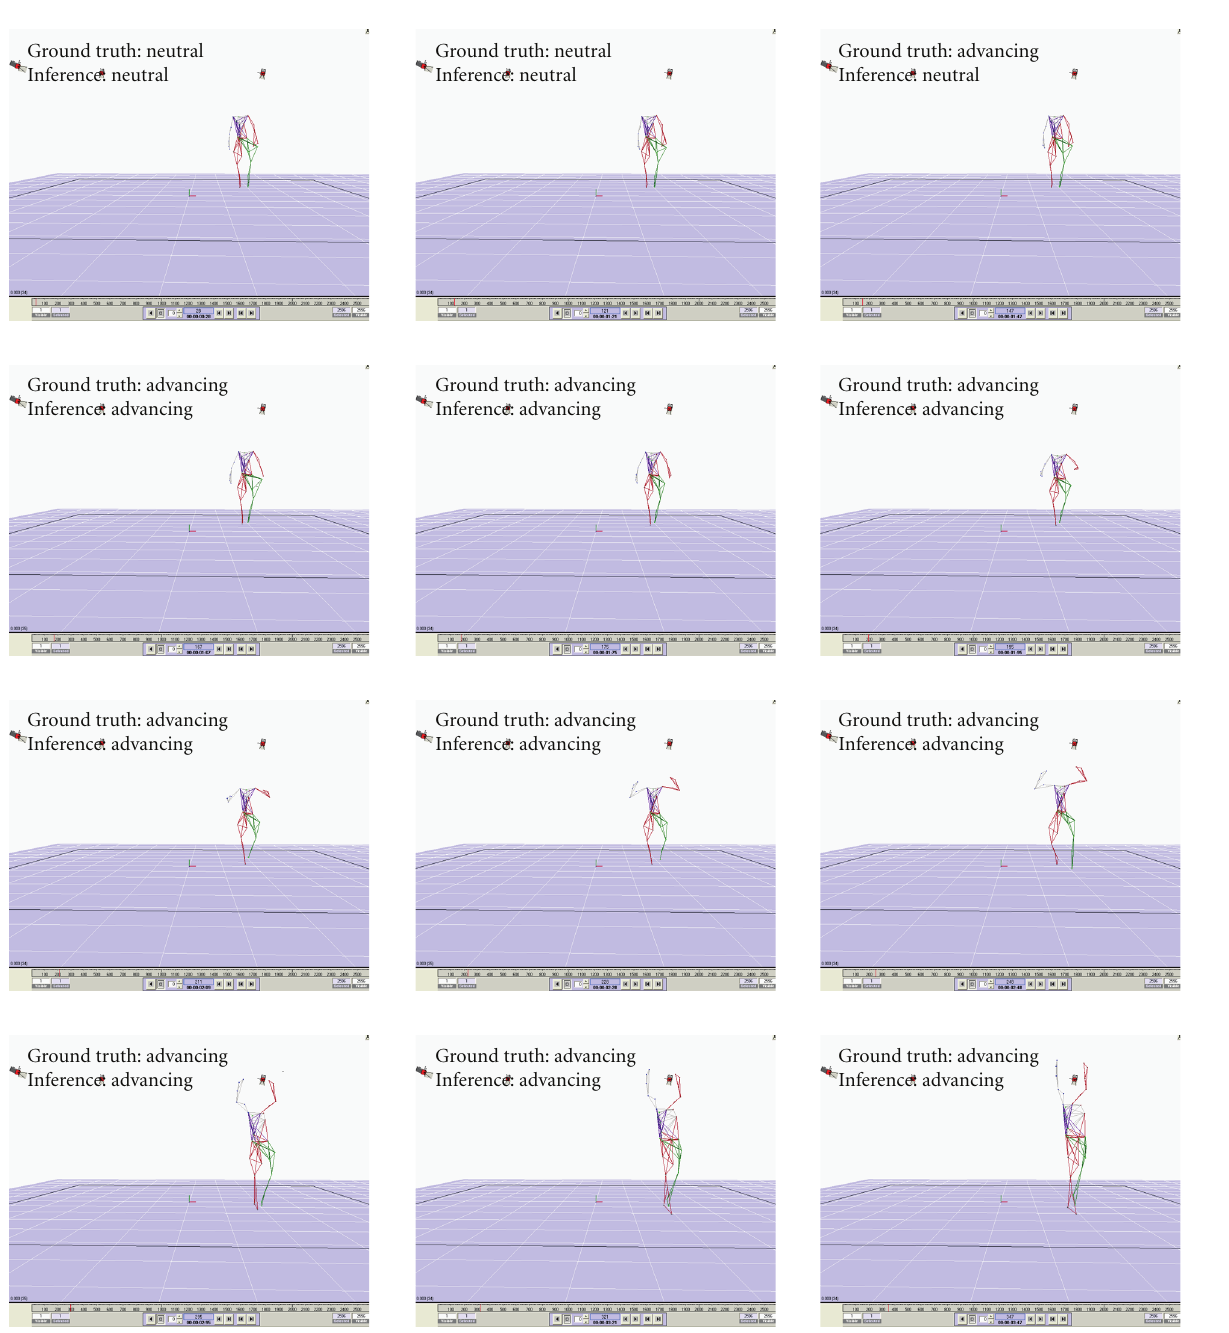
Figure 11: Image sequence of “Menu 3” (dancer 1) movement data showing the ground truth and inference results of the dominant Shape quality expressed between frames